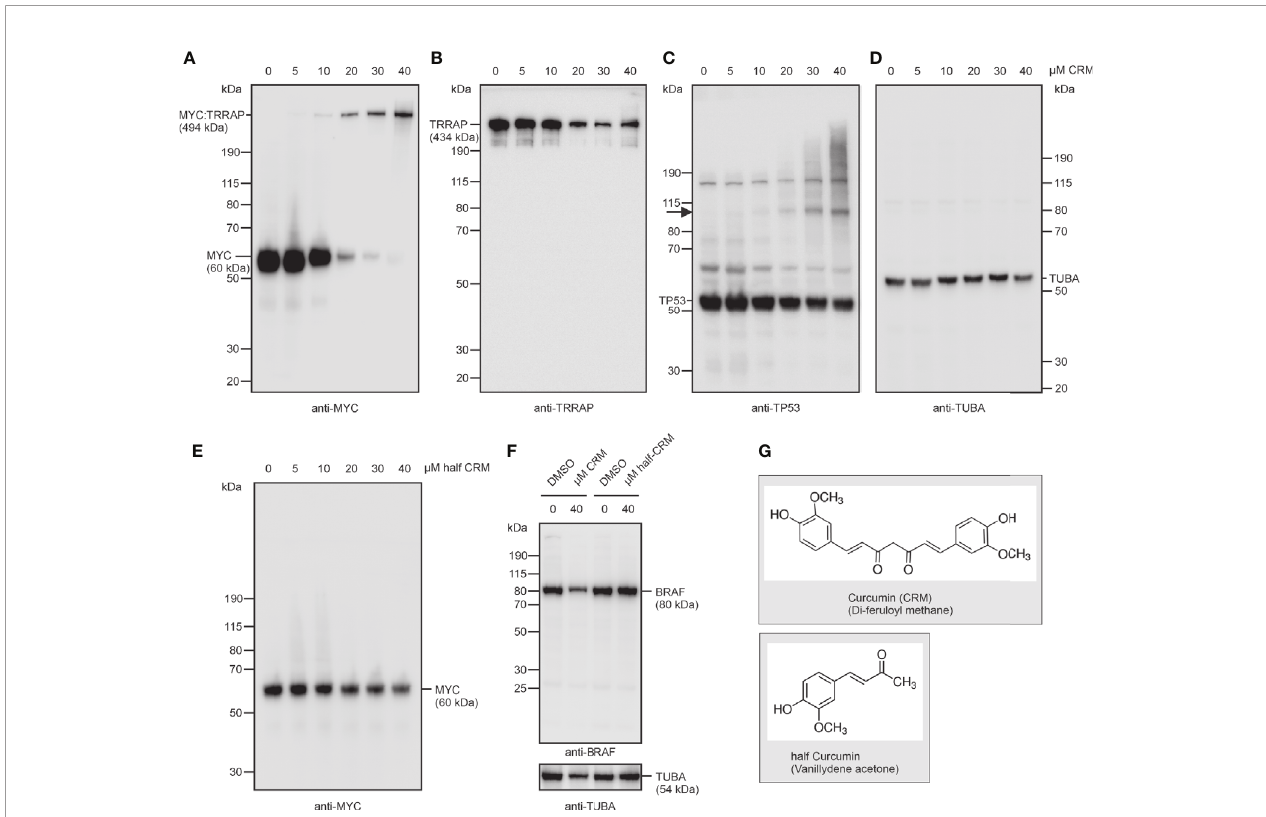
FIGURE 4 | Curcumin leads to speci fi c downregulation of the MYC protein thereby inducing a cross-link with TRRAP. (A – D) HEK293T cells were incubated with increasing concentrations (5 – 40 µM) of curcumin. Protein extracts were prepared after 24 h and analyzed by immunoblotting using (A) MYC-, (B) TRRAP ‑ , (C) TP53, or (D) a -tubulin speci fi c antibodies. The arrow in (C) depicts the position of a potential cross-linked TP53 dimer. (E) HEK293T cells were incubated with increasing concentrations (5 – 40 µM) of half-curcumin and tested for MYC expression as under (A) . (F) Expression analysis of the BRAF oncoprotein in the presence or absence of curcumin, or half-curcumin as described under (A, E) . (G) Structural formulas of curcumin (CRM) and of a non-functional curcumin-derivative termed half- curcumin. A representative experiment (n = 2) is shown (A – F)